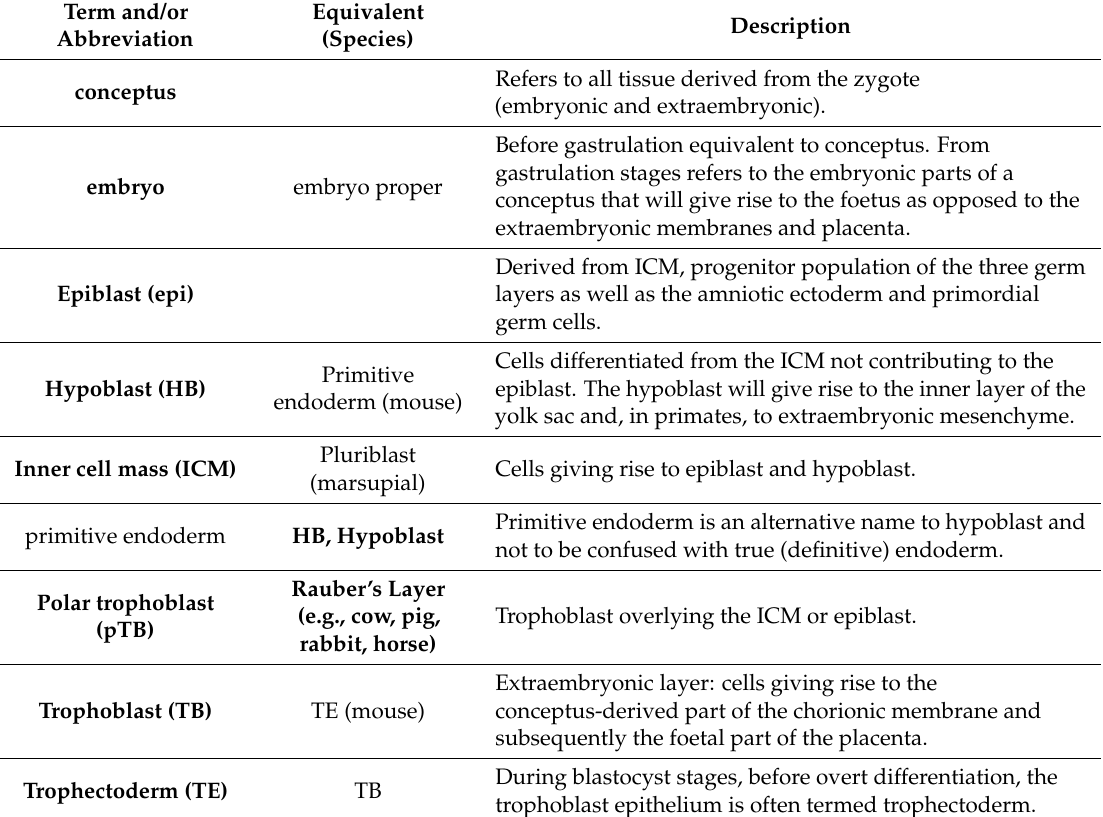
Table 1. Glossary of embryological terms (in bold), alternatives often used (in regular font) in various species and their definition as used in this